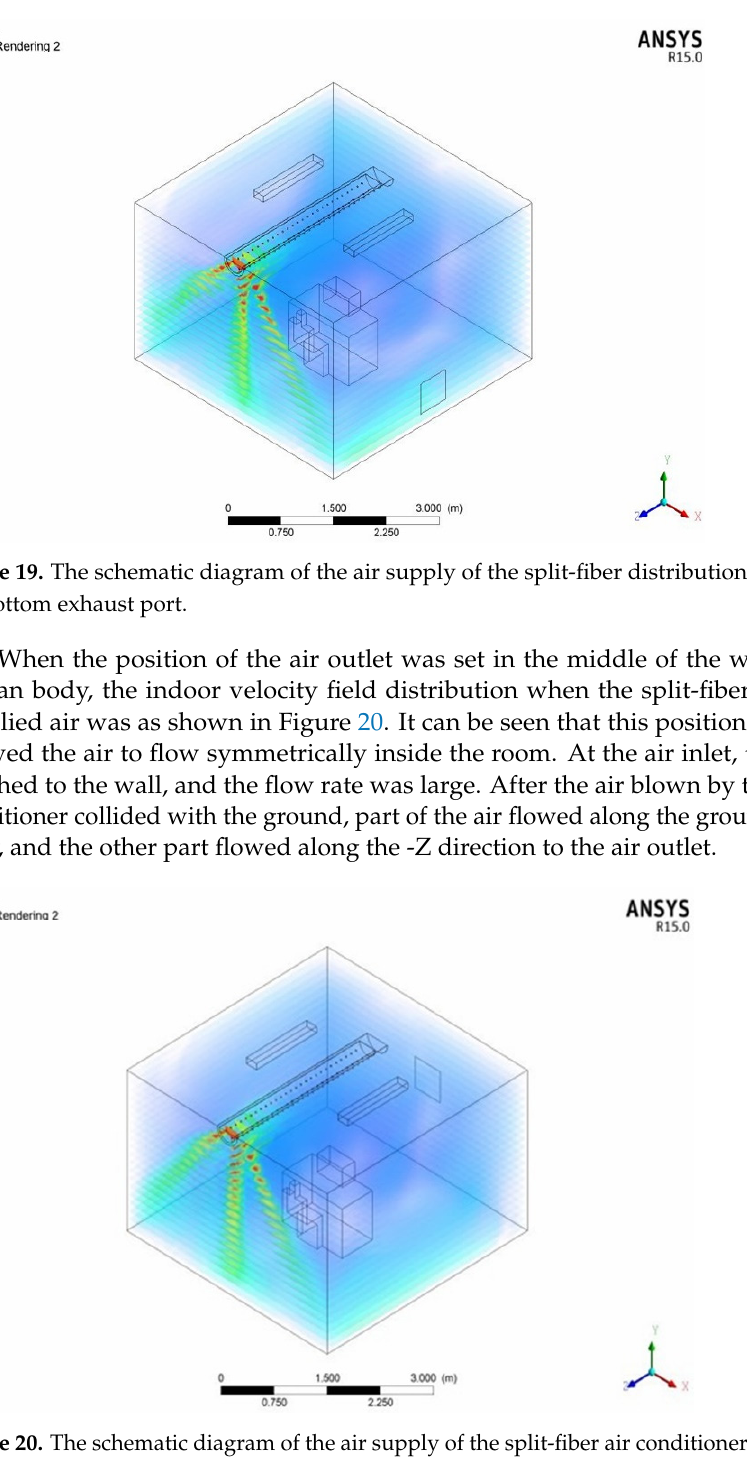
Figure 18. The schematic diagram of the air supply of the split-fiber distribution air conditioner at the upper air outlet.